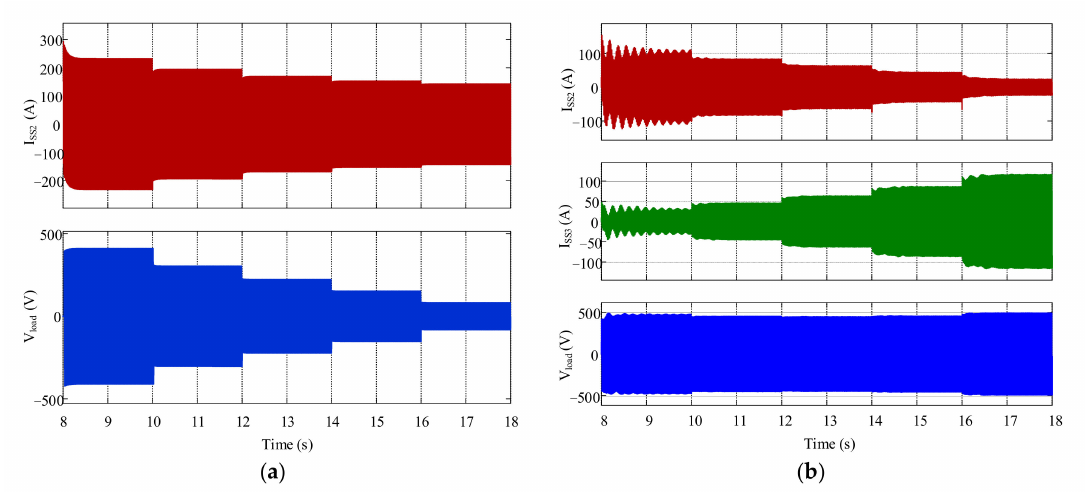
Figure 13. Output current and load voltage of different traction grids: ( a ) the traditional traction grid ( b ) the proposed AC co-phase traction